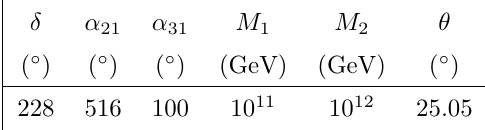
Table 3 . A benchmark point for leptogenesis with M 1 = 10 11 GeV and N 3 decoupled with a normal ordered light mass